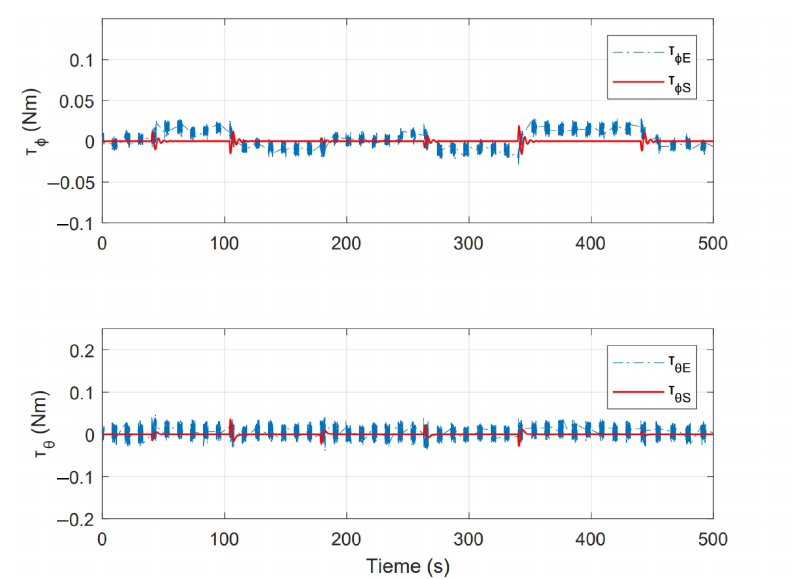
Figure 18. Control inputs presented in state feedback experiment.